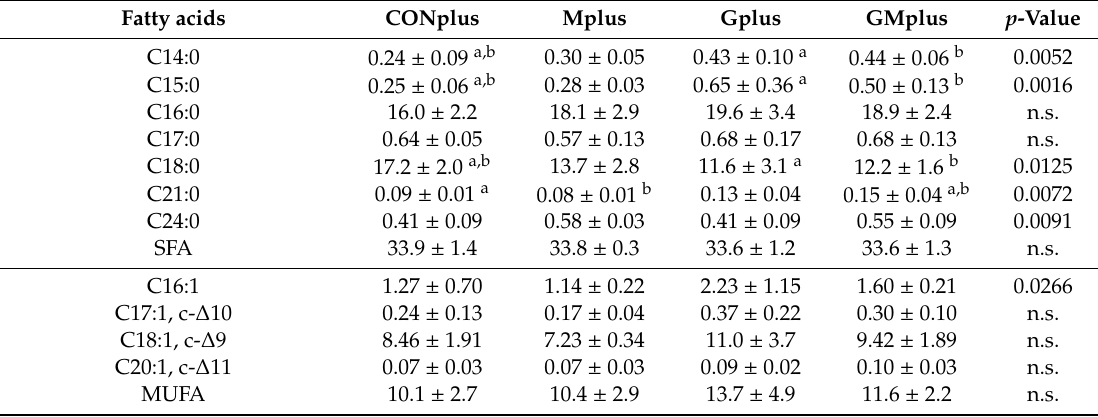
Table 1. Fatty acids (FA) percentage share in total FA pool in serum of experimental groups treated with chemical carcinogen